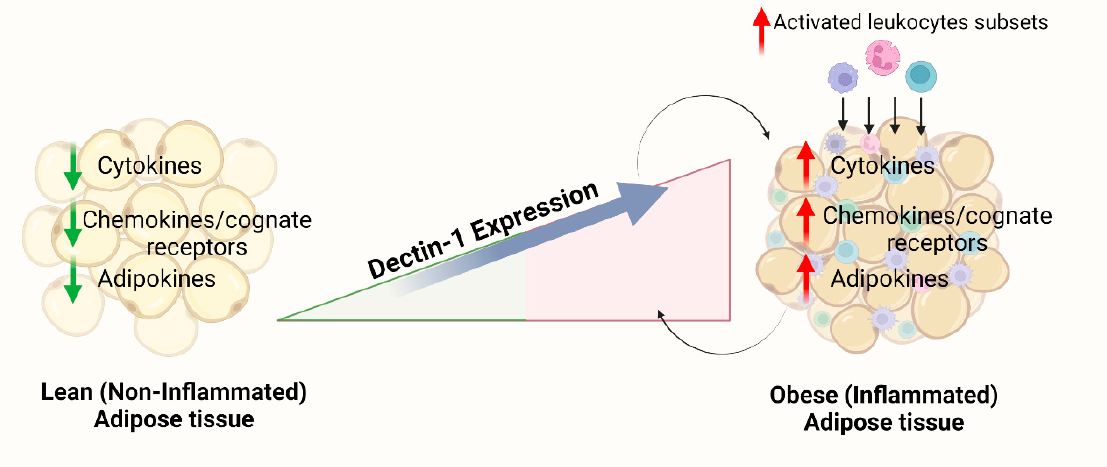
Figure 3. Schematic representation of dectin-1 and their association with metabolic inflammation in the context of obesity. Generated by BioRender software license number PM247G7WOB.